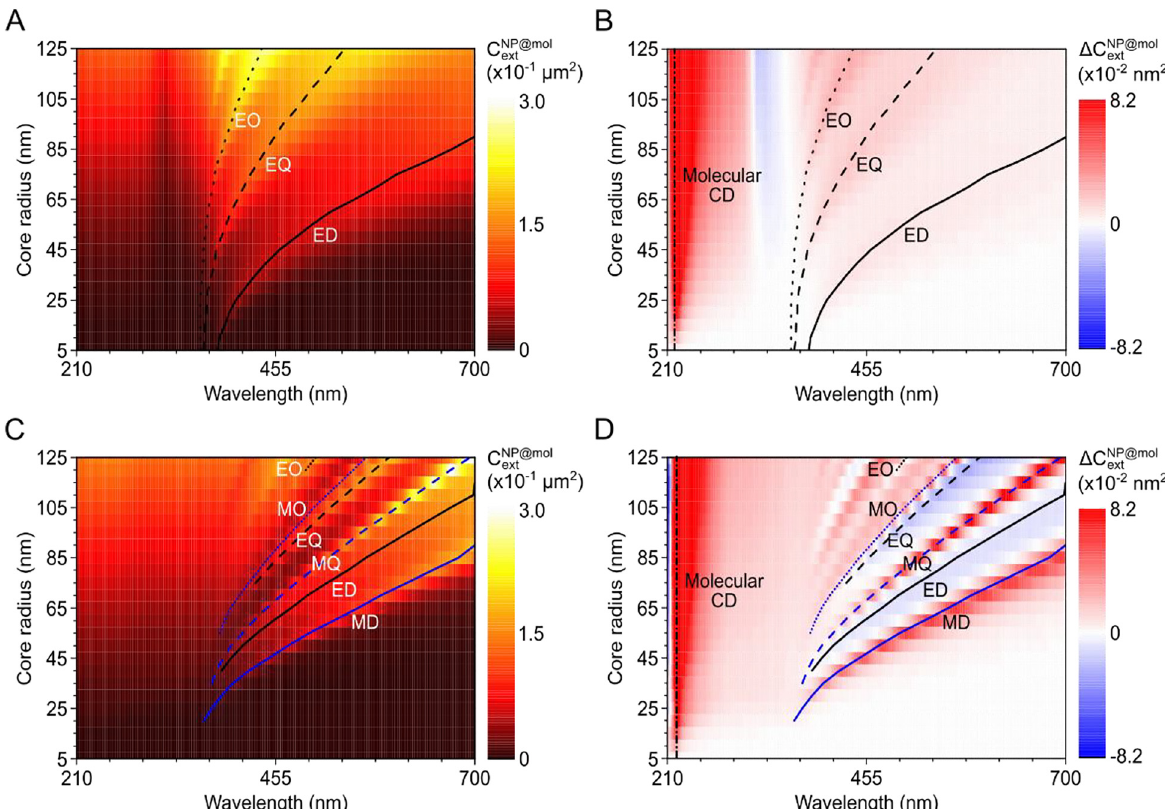
Figure3: Theextinctionandcirculardifferentialextinctioncrosssectionofplasmoniccore-chiralshellanddielectriccore-chiralshellnanoparticles. (A)Theextinctioncrosssectionand(B)thecirculardifferentialextinctioncrosssectionofsilvercore-chiralshellnanoparticle.(C)Theextinctioncross sectionand(D)thecirculardifferentialextinctioncrosssectionofsiliconcore-chiralshellnanoparticle.Thethicknessofthechiralmolecularshellis fixed at 1 nm. The ED (black solid), EQ (black dashed), EO (black dotted), MD (blue solid), MQ (blue dashed), and MO (blue dotted) resonance positions are plotted. The black dashed-dotted line shows the molecular intrinsic CD resonance at 220